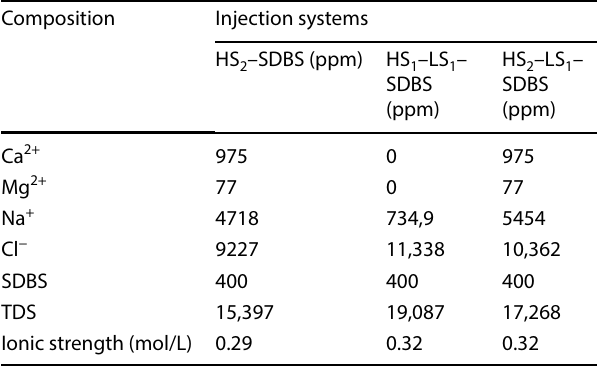
Table 3 Final compositions of brines in dynamic contact angle measurements for low salinity injections